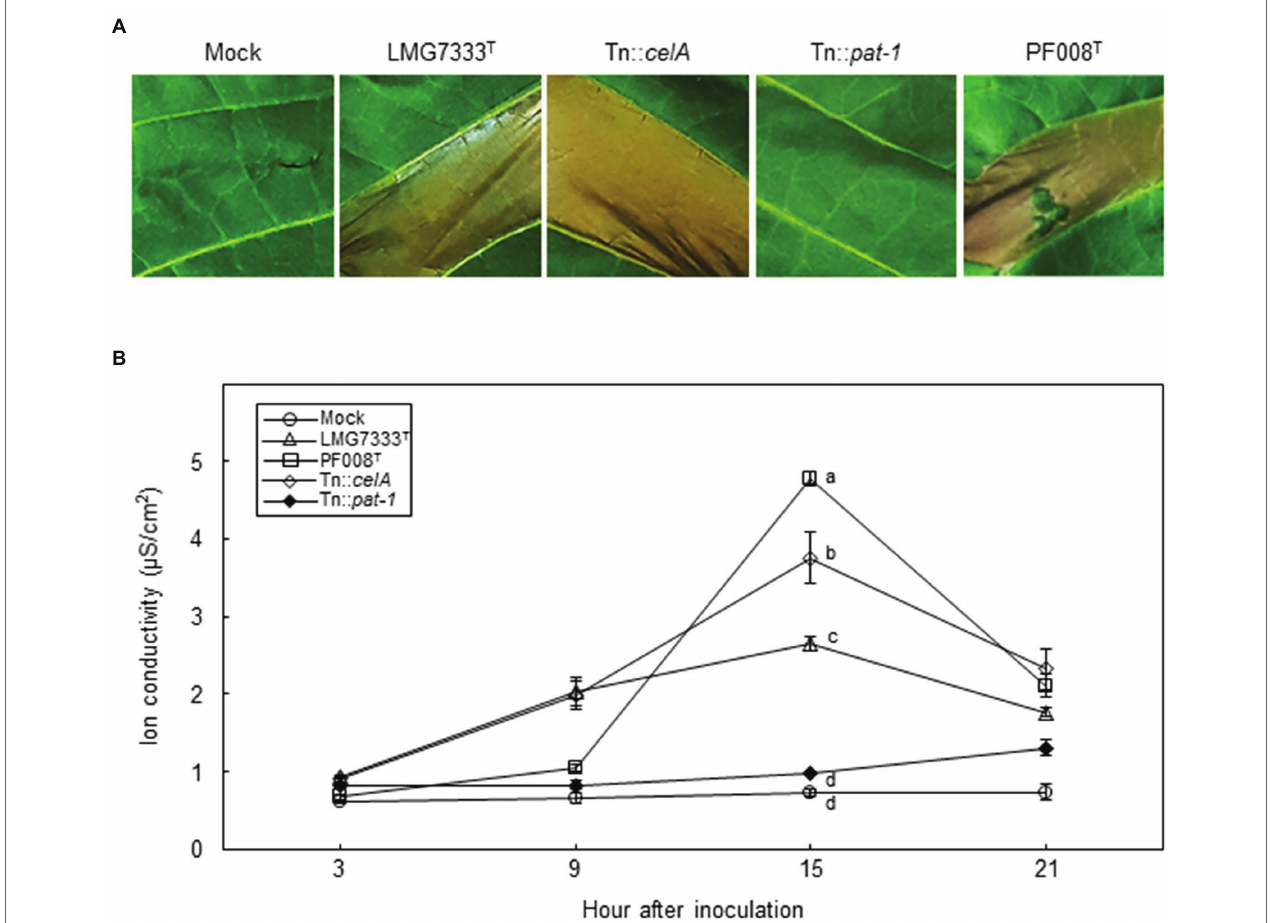
FIGURE 7 | Influence of two major virulence genes of C . michiganensis for HR-like cell death on N . tabacum leaves. (A) The HR-like cell death on N . tabacum leaves by infiltration with 10 8 CFU/ml of C . capsici PF008 T , C . michiganensis LMG7333 T , and its mutant strains. Photos showing HR-like cell death were taken at 18 h after infiltration (hai), respectively. (B) The measurement of ion conductivity on N . tabacum leaves after inoculation with 10 8 CFU/ml of the bacterial strains. The letters at the time points in the graphs indicate a statistically significant difference analyzed via Duncan’s multiple range test ( p < 0.05). Similar results were obtained from two independent assays. Mock, 10 mM MgCl 2 .